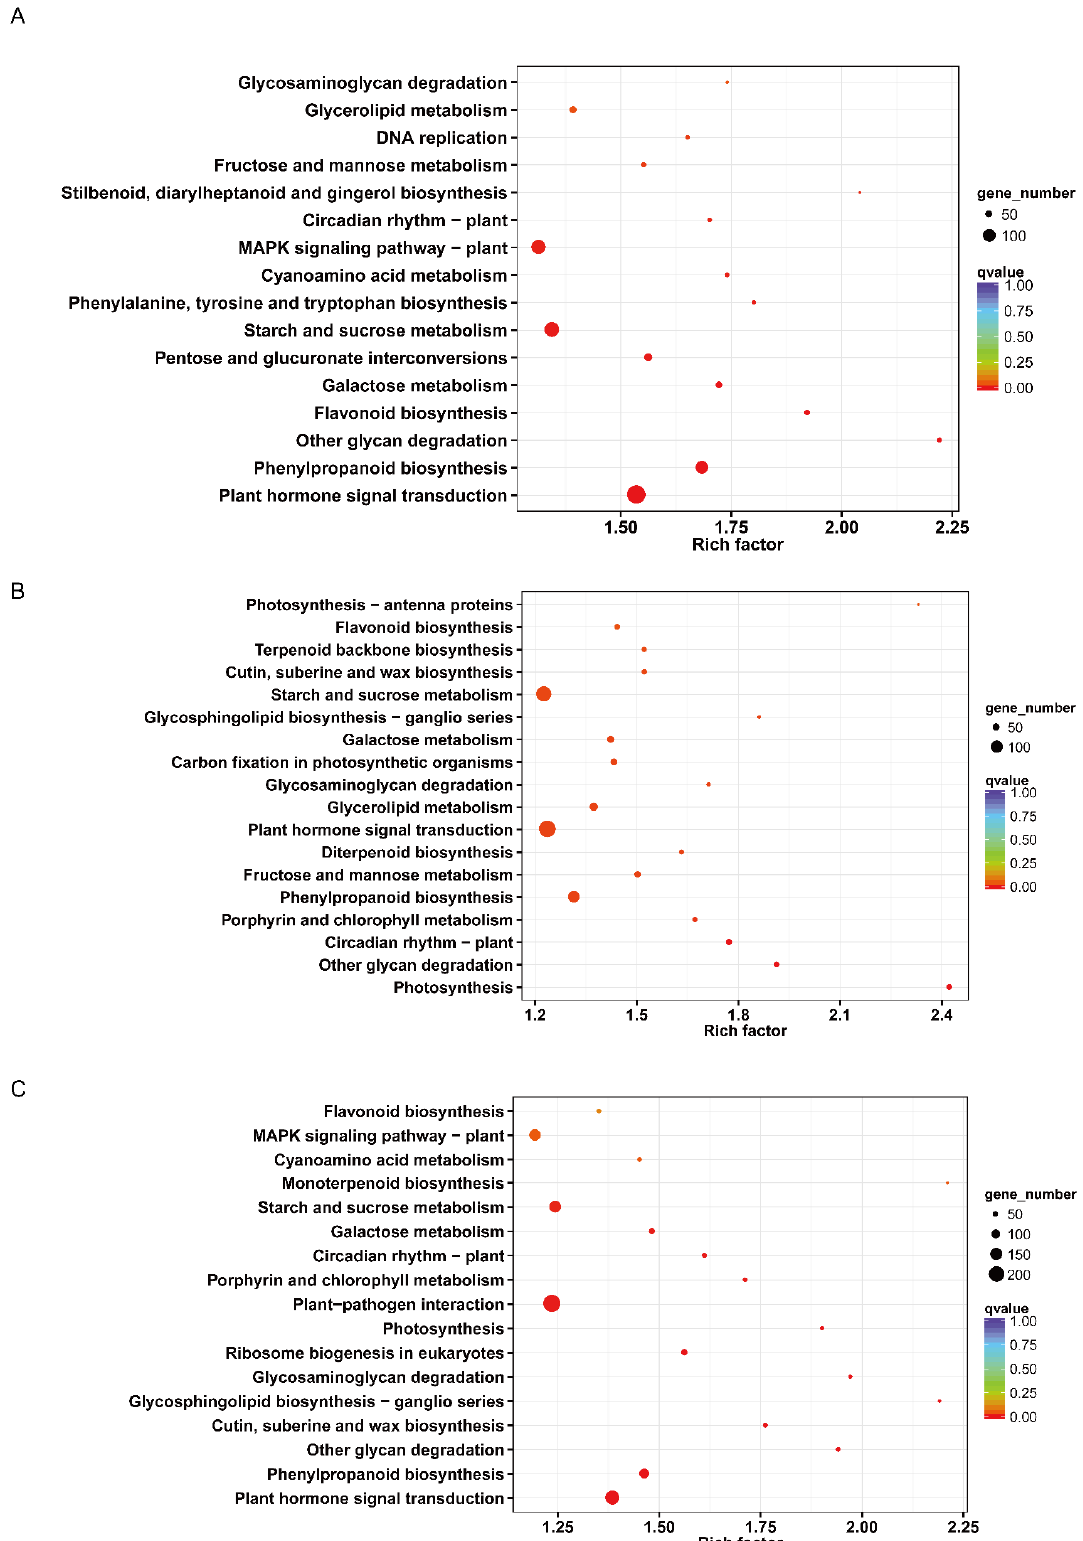
Figure 4. KEGG pathway enrichment of DEGs, ( A ) with S2/S1, ( B ) with S3/S1, and ( C ) with S4/S1. The rich factor indicates the ratio of the DEGs amount to the total amount of annotated genes in the pathway.